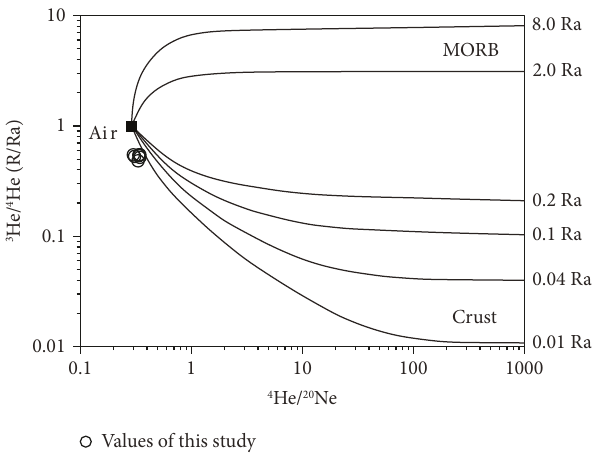
Figure 8: Plots showing 3 He/ 4 He (R/Ra) versus 4 He/ 20 Ne values for gas samples from the seven soil gas wells.